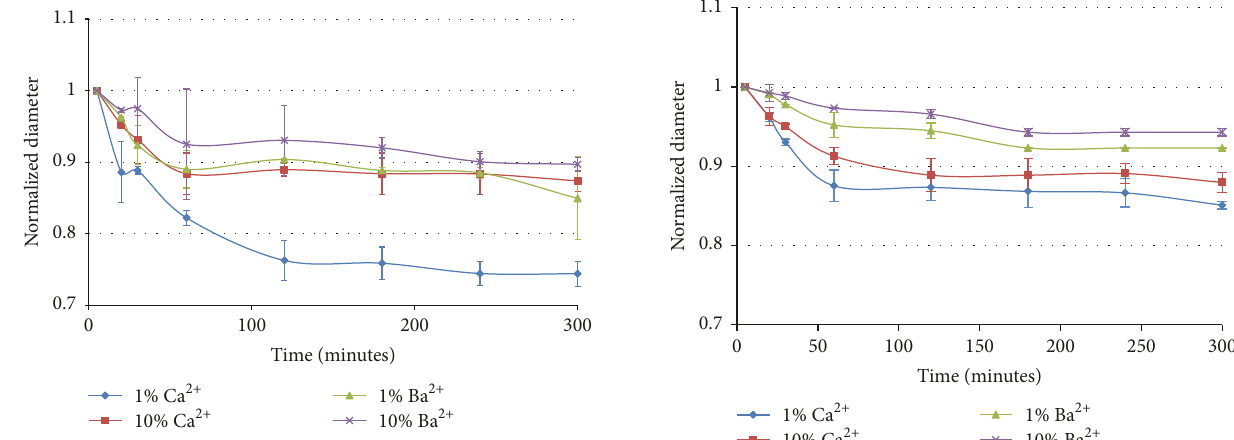
Figure 5: Normalized diameters of alginate beads incubated in different concentrations of Ca 2+ and Ba 2+ at a low temperature (8 ∘ C) for various gelling